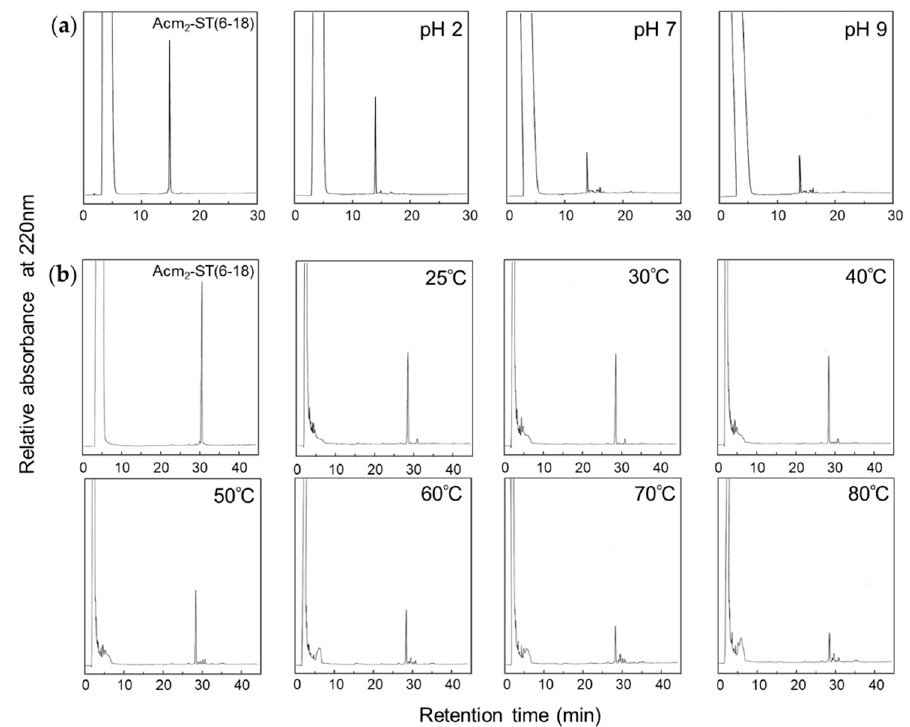
Figure 3. ( a ) RP-HPLC profiles of Acm 2 -precursor peptide and the reaction solutions after I 2 -oxidation in 50% MeOH at pH 2, pH 7, and pH 9 with a linear gradient from 10 to 50% CH 3 CN in 40 min (l.0% / min). ( b ) RP-HPLC profiles of Acm 2 -precursor peptide and the reaction solutions after I 2 -oxidation in 50% tetrahydrofuran (THF) at 25–80 ◦ C with a linear gradient from 10 to 40% CH 3 CN in 60 min (0.5% / min) after 10 min of